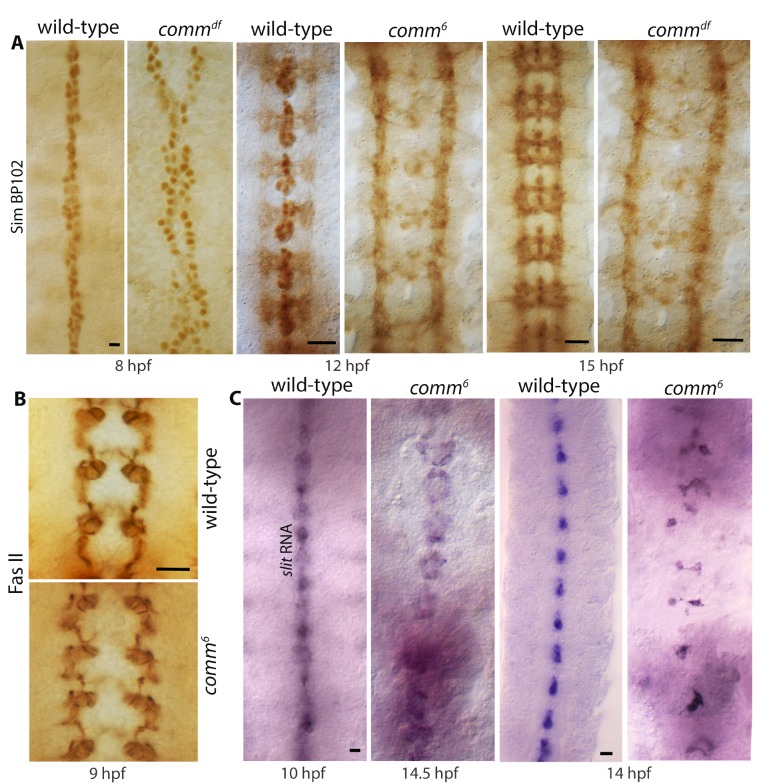
Loss of function for comm shows significant midline defects.(A): Sim and BP102-double stained embryos. Note the disorganization of the midline, which begins during early neurogenesis and is discernible by 8 hpf. Sim has a midline expression, BP102 has a ladder-like pattern. Scale bar: 8 μm. (B): Fas II stained wild-type and comm mutant embryos. The initial position of the medial tract in comm is farther apart than in wild-type even at an early stage. Scale bar: 20 μm. (C): Whole-mount RNA in situ for slit in wild-type and comm mutant embryos. Note that Slit-positive midline glial cells fail to organize into a single file of cells along the midline in comm mutants. Scale bar: 8 μm.